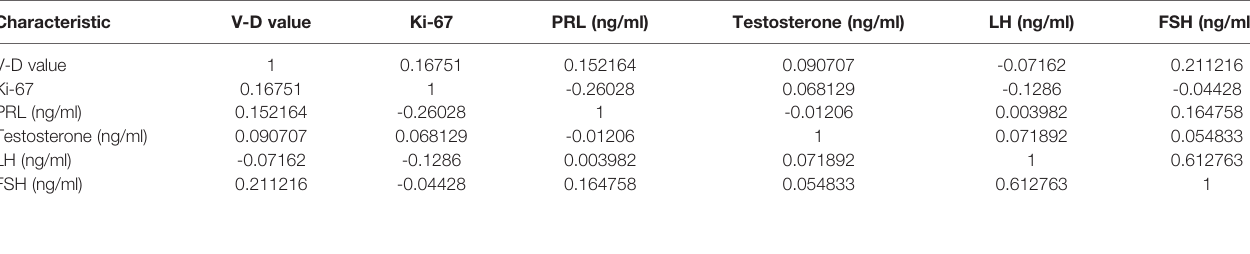
TABLE 2 | Correlation between V-D value, Ki-67 and other hormone levels. Characteristic